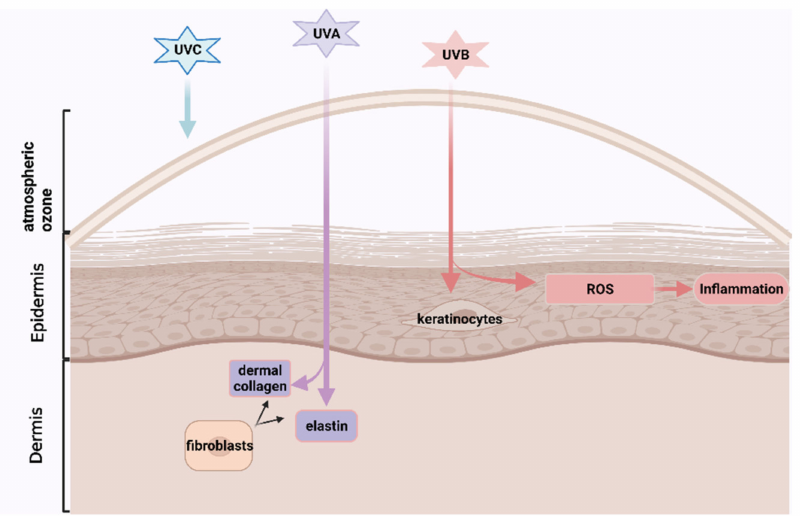
Figure 1. The mechanisms that UV-rays promote skin photoaging (created with BioRender.com. https://app.biorender.com/illustrations/61123dbdedaefd00a5e711d7. Accessed on 12 August